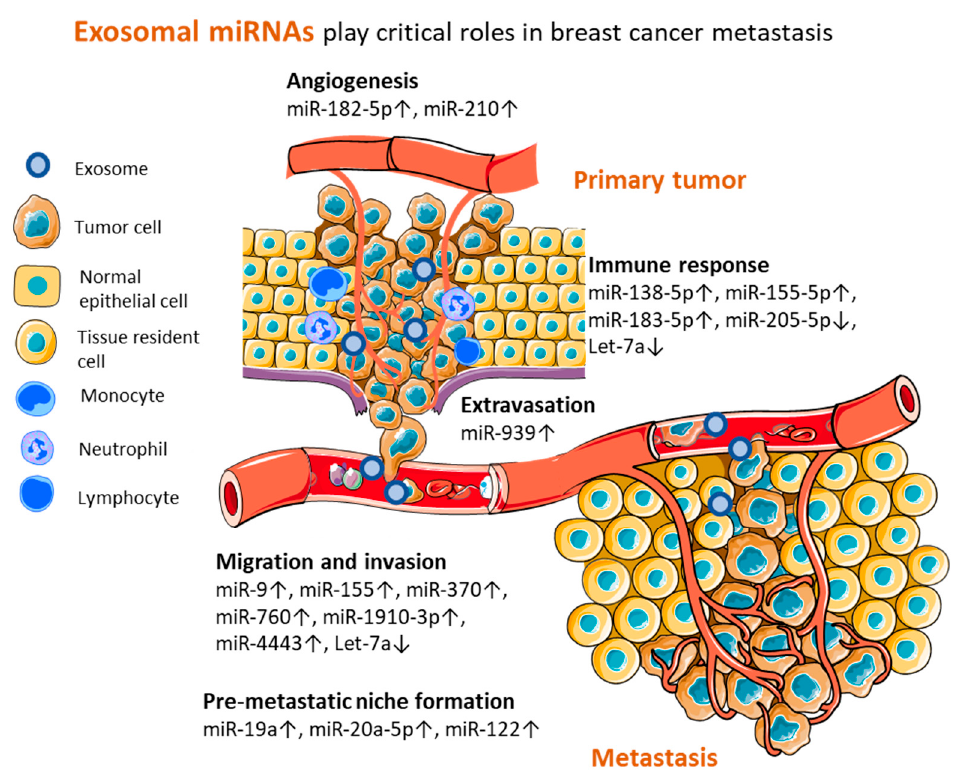
Figure 3. Exosome miRNAs identified by preclinical studies as relevant for breast cancer progression. During the metastatic cascade, exosomal miRNAs released by cancer cells play a pivotal role by regulating key steps, such as angiogenesis, immune evasion, extravasation, migration, and invasion, and the formation of the pre-metastatic niche. In vitro and in vivo studies suggest that these miRNAs could represent potential biomarkers for breast cancer metastasis but require further investigation in liquid biopsy samples.